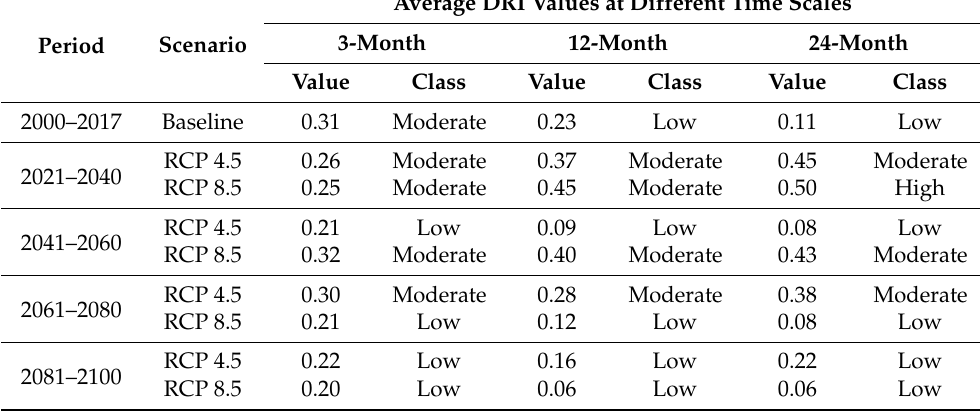
Table 5. Average Drought Risk Index values for the Lam Phaniang River Basin at different time scales under RCPs 4.5 and 8.5 during